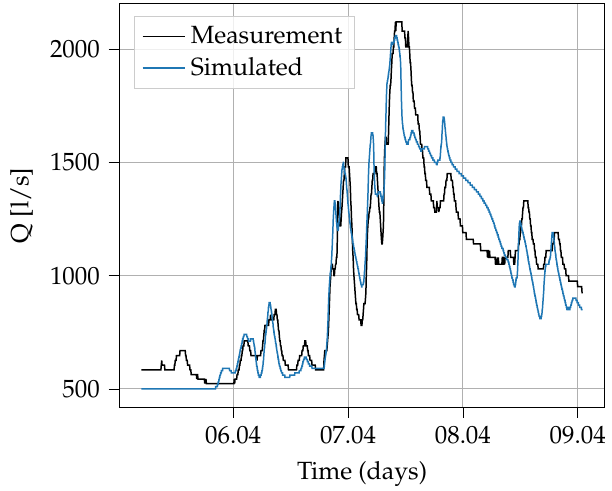
Figure 7. Comparison of measured and calculated flow for a rain event in April 2022.